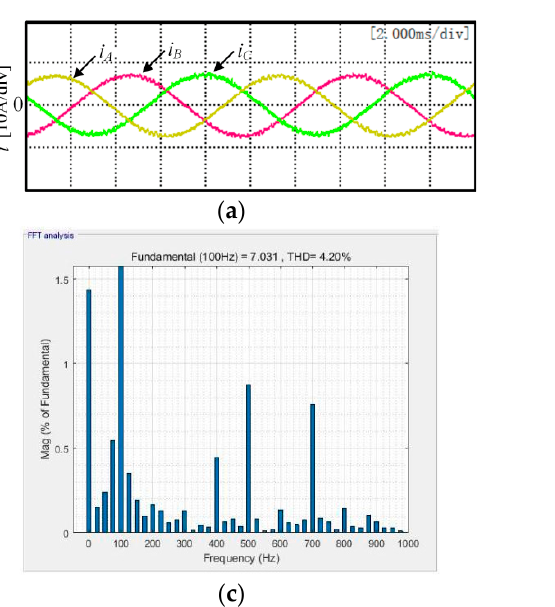
Figure 11. Comparison of reactive power variation under different frequency when inductance changes suddenly: ( a ) Inductance change of traditional control scheme at 100 Hz; ( b ) Inductance change of proposed control scheme at 100 Hz; ( c ) Inductance change of traditional control scheme at 400 Hz; ( d ) Inductance change of proposed control scheme at 400 Hz.